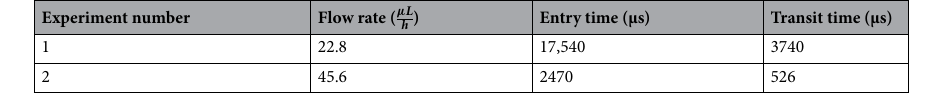
Table 2. The extracted entry time and transit time for the cell radius of 6.5 μm at two flow